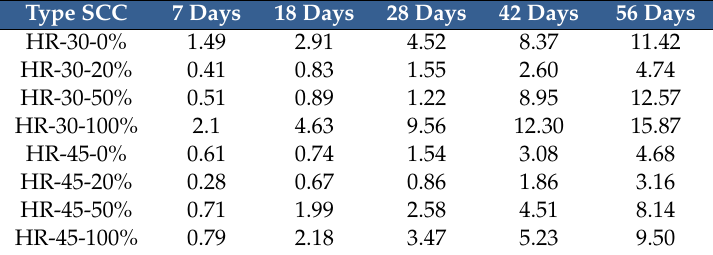
Table 5. Weight loss results in freeze-thaw